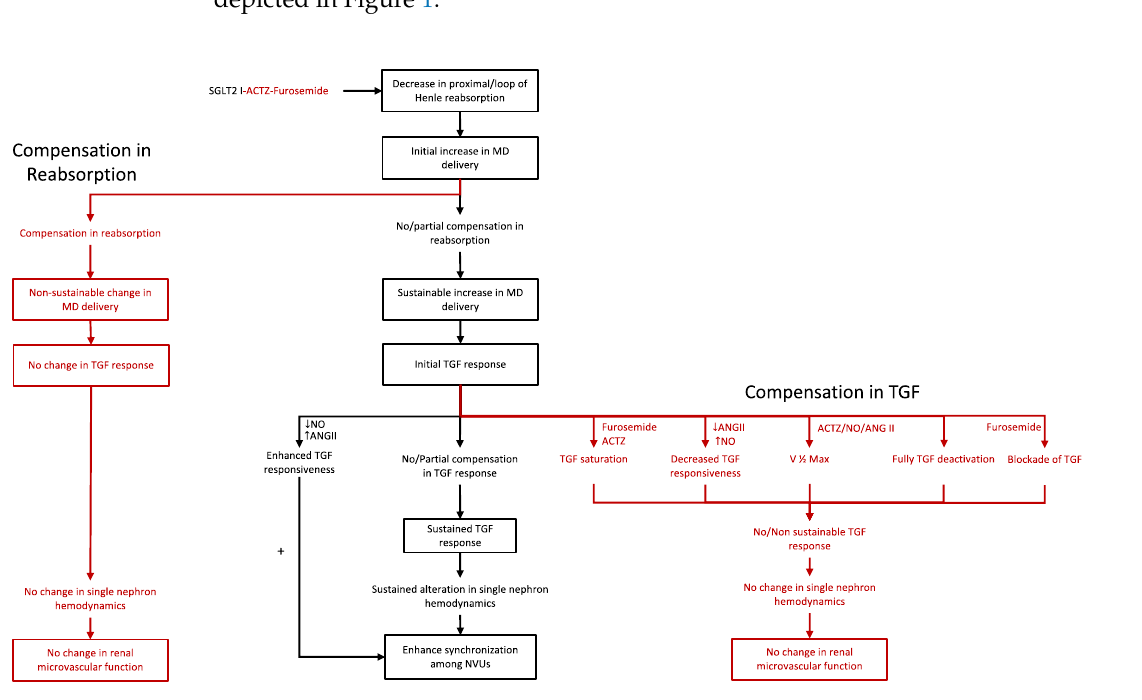
Figure 1. Compounds and conditions that sustainably activate the tubuloglomerular feedback (TGF) mechanism. Compounds that decrease solute reabsorption in the proximal tubule/loop of Henle can sustainably increase macula densa (MD) delivery unless there is a compensation in the reabsorption in segments proximal to the macula densa ( left ). Sustained increase in macula densa delivery would lead to sustained activation of the TGF system unless there is a compensation in the TGF response ( right ). Sustained activation of the TGF mechanism would result in sustained alteration of single nephron hemodynamics and presumable enhancement of synchronization among nephrovascular units (NVUs) ( center ).